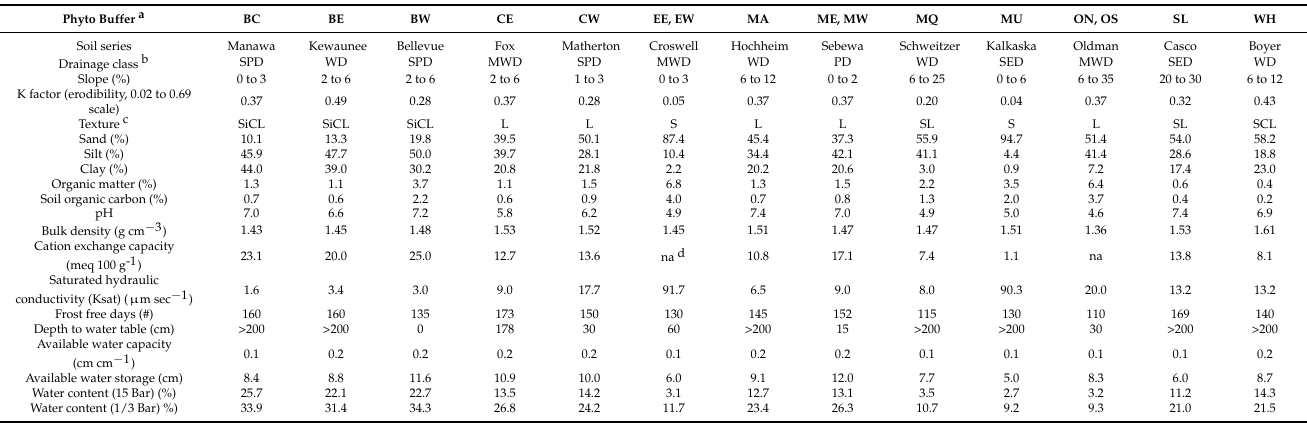
results. In the current study, separate analyses were conducted for each buffer group. Each set of buffer group clones consisted of genotypes that have: (1) been commonly used for commercial and/or research purposes in the region (i.e., Common clones), (2) a rich history of testing but are still at the experimental stage (i.e., Experimental), and (3) been bred, tested, and selected at the University of Minnesota Duluth, Natural Resources Research Institute (NRRI) and show promise for broad-ranging applications (i.e., NRRI) [46,56]. Specific clones and their genomic groups are listed in Table 3. Table 2. Soil properties of sixteen phytoremediation buffer systems (i.e., phyto buffers) comprising a regional phytotech- nologies network established from 2017 to 2019 in the Lake Superior watershed of the Upper Peninsula of Michigan, USA and the Lake Michigan watershed of eastern Wisconsin, USA.